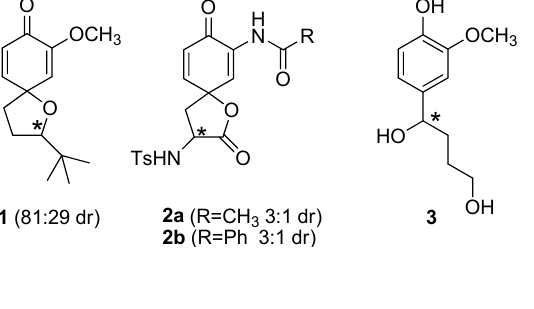
Figure 1. Locations of the chiral centre in spirocompounds and phenol.